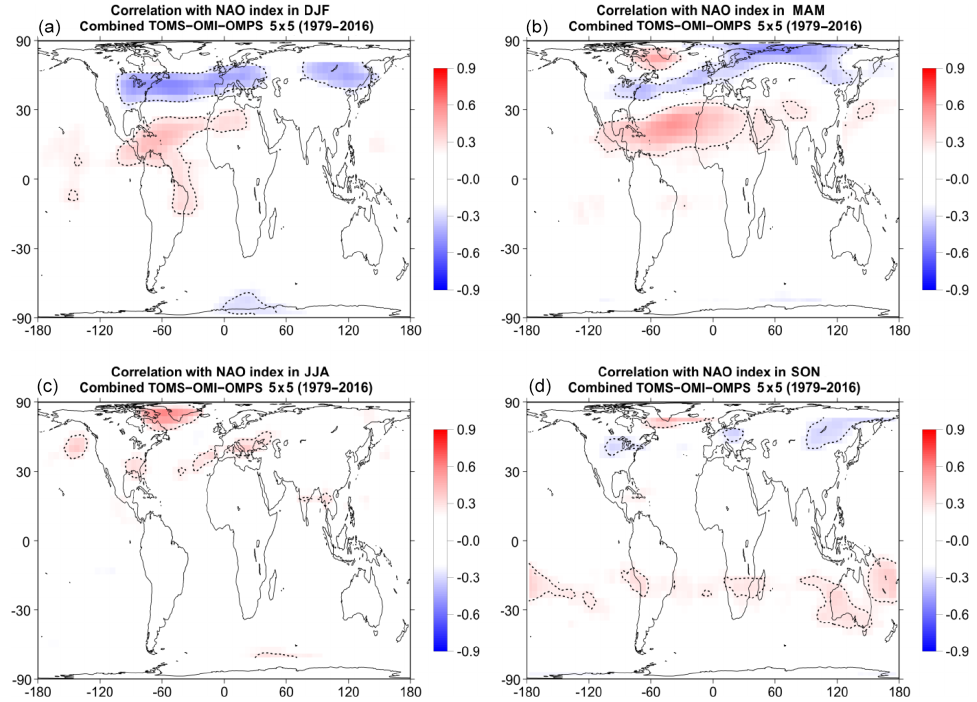
Figure A2. Map of correlation coefficients between total ozone from TOMS–OMI–OMPS satellite data and the NAO index during winter (December, January, and February – DJF; a ), spring (March, April, amd May – MAM; b ), summer (June, July, and August – JJA; c ), and autumn (September, October, and November – SON; d ) for the whole period 1979–2016, after removing variability related to the seasonal cycle, QBO, solar cycle, and ENSO. The dotted line binds the regions where the correlation coefficients are statistically significant at the 99% confidence level ( t test). Only correlation coefficients above or below ± 0 . 2 are shown. Ozone data for the period 1991–1993 after the Mt Pinatubo eruption were not used in the correlation analysis to avoid any data contamination by the volcanic